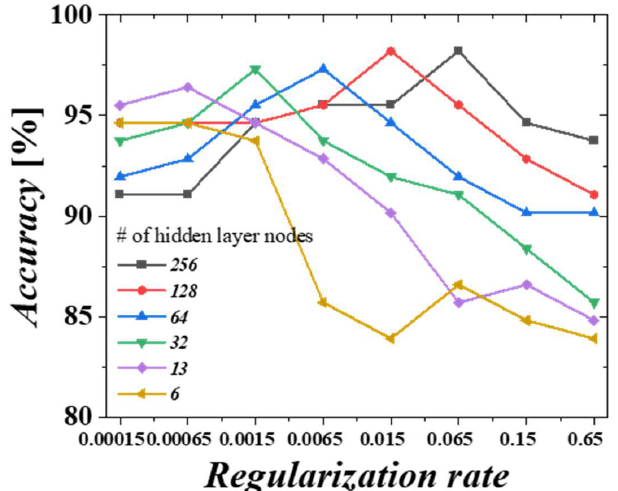
Figure 12. Validation data accuracy vs. regularization rate of the STM-LSTM-based fall detection system with respect to different number of hidden layer nodes.